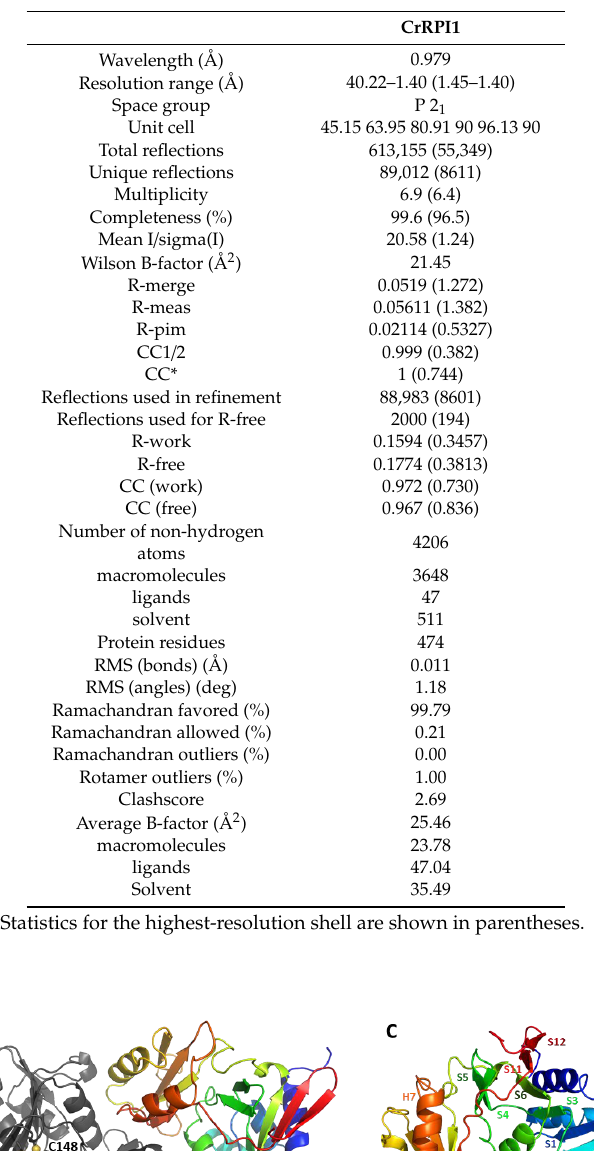
Table 1. Crystallographic data collection and refinement statistics.